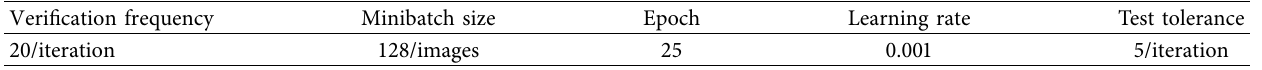
Table 2: Training parameter setting.